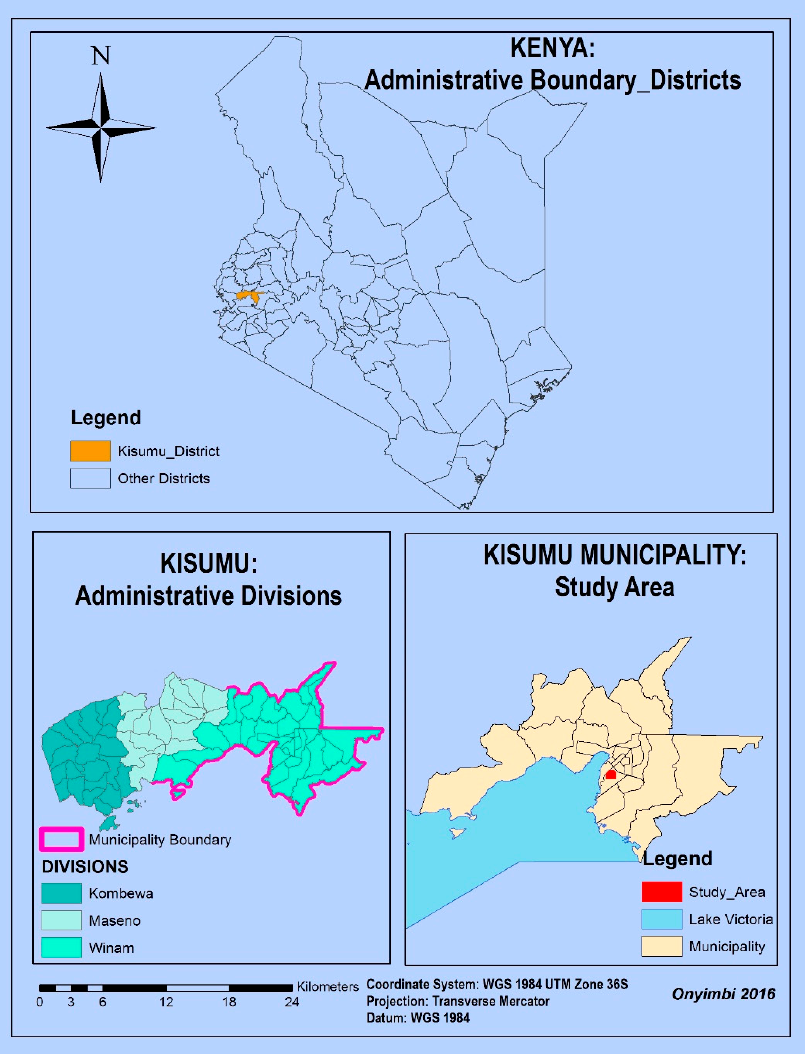
Figure 1. Study area. Source: author’s construct.